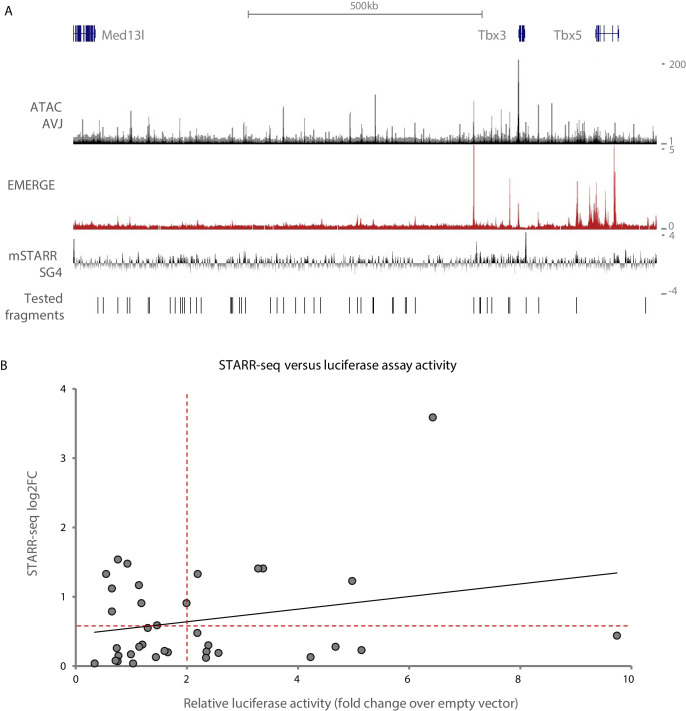
Discrepancy between STARR-seq activity and luciferase reporter activity of selected regions.(A) Overview of the murine Tbx3 locus with ATAC_AVJ, EMERGE and STARR_SG4 data. Fragments selected for luciferase assay, selected either on STARR-seq activity or EMERGE/ATAC peaks are depicted below. (B) Correlation between luciferase reporter activity (fold change of reporter activity over activity of empty pGL2-SV40 vector; threshold FC >2) and STARR-seq (log2FC of SG4 over pcDNA control; threshold log2FC >0.58 (FC >1.5)) of selected fragments.